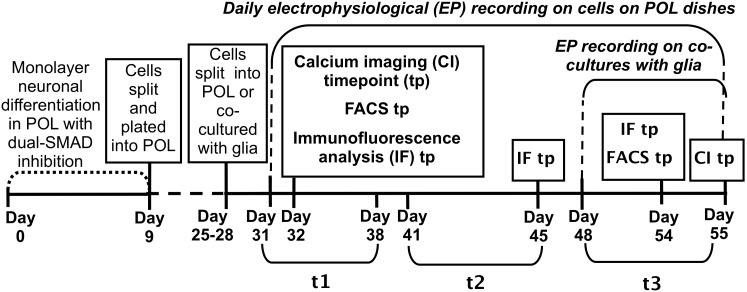
Timeline of the experiments.The different steps of the experiments are represented, as well as the time-points for the electrophysiological, calcium imaging, immunofluorescence and FACS analyses. The 3 different timing groups for statistical purposes are the following: t1  =  from day 31 to day 38; t2  =  from day 41 to day 45; t3  =  from day 48 to day 55.